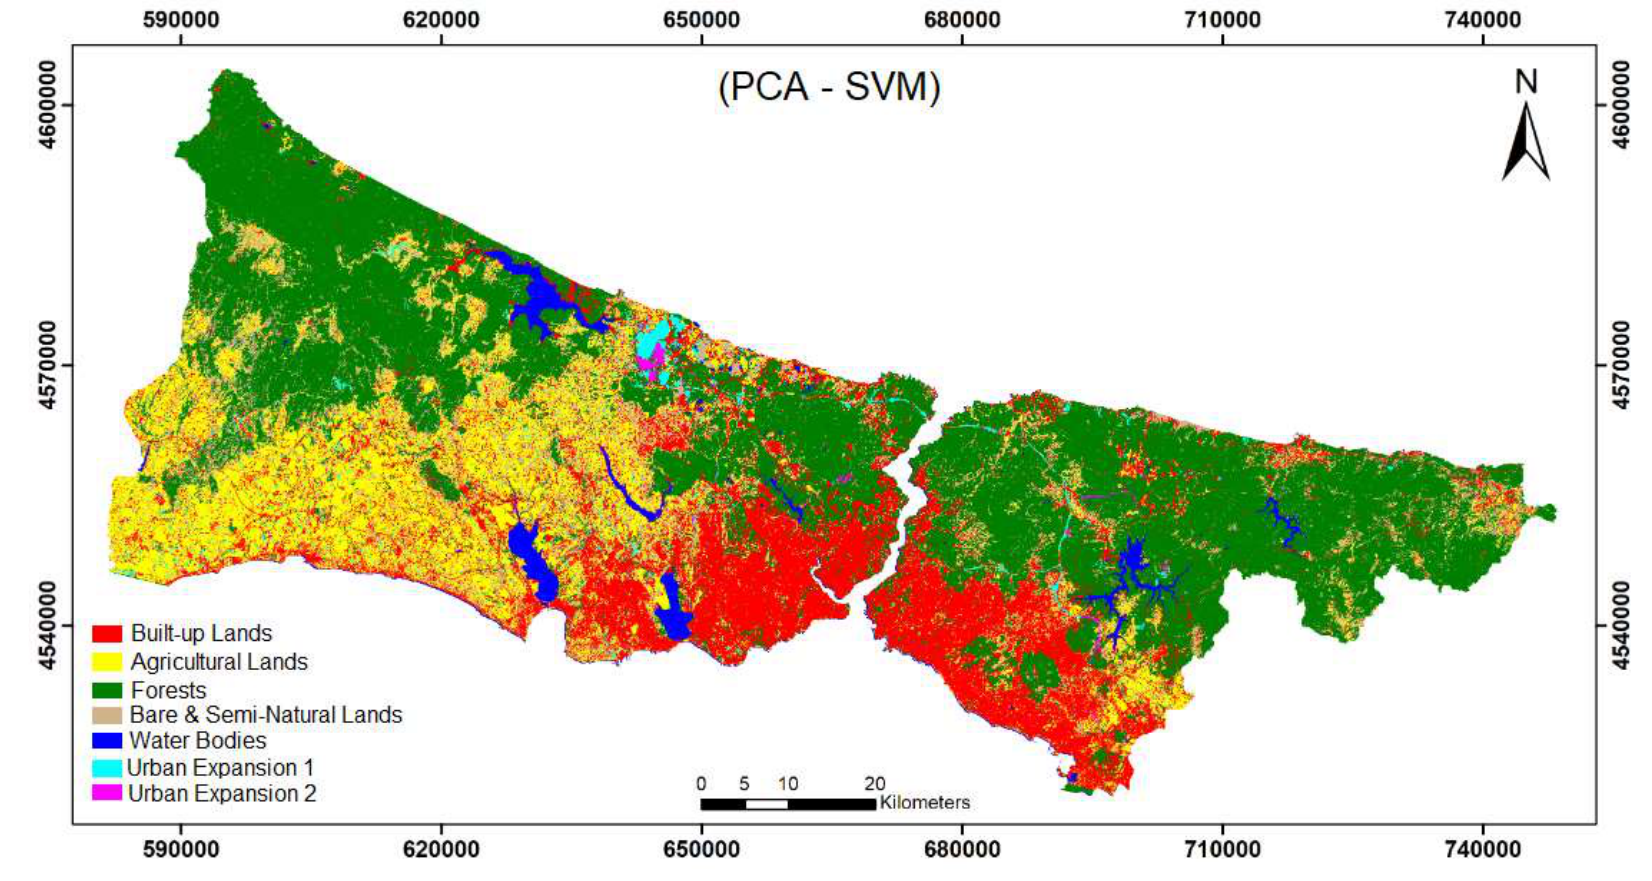
Figure A6. SVM classification results of the PCA dataset.